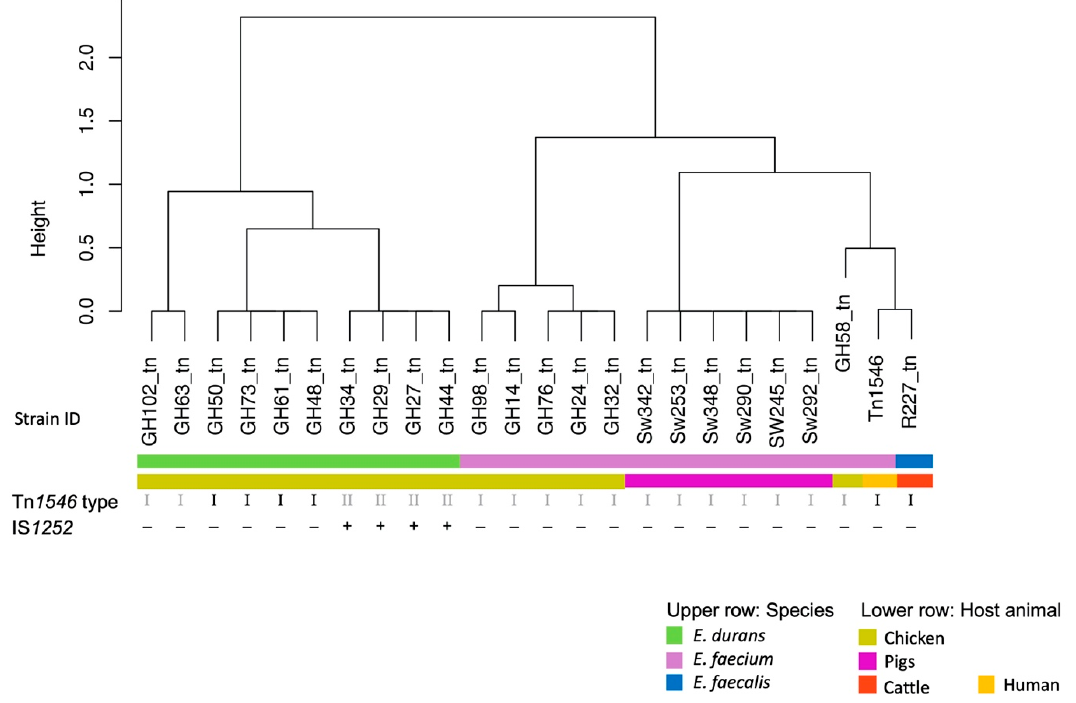
Figure 1. Average nucleotide identity (ANI) based cluster dendrogram showing three types of Tn 1546 -like elements carrying vanA operons identified in 23 vanA - type vancomycin-resistant enterococci from healthy food-producing animals. Type I corresponds to the prototype Tn 1546 (GenBank M97297) from human E. faecium B4147 [35]. Type II additionally carries an IS 1252 in the orf2 - vanR intergenic region. Changed information is highlighted in grey.